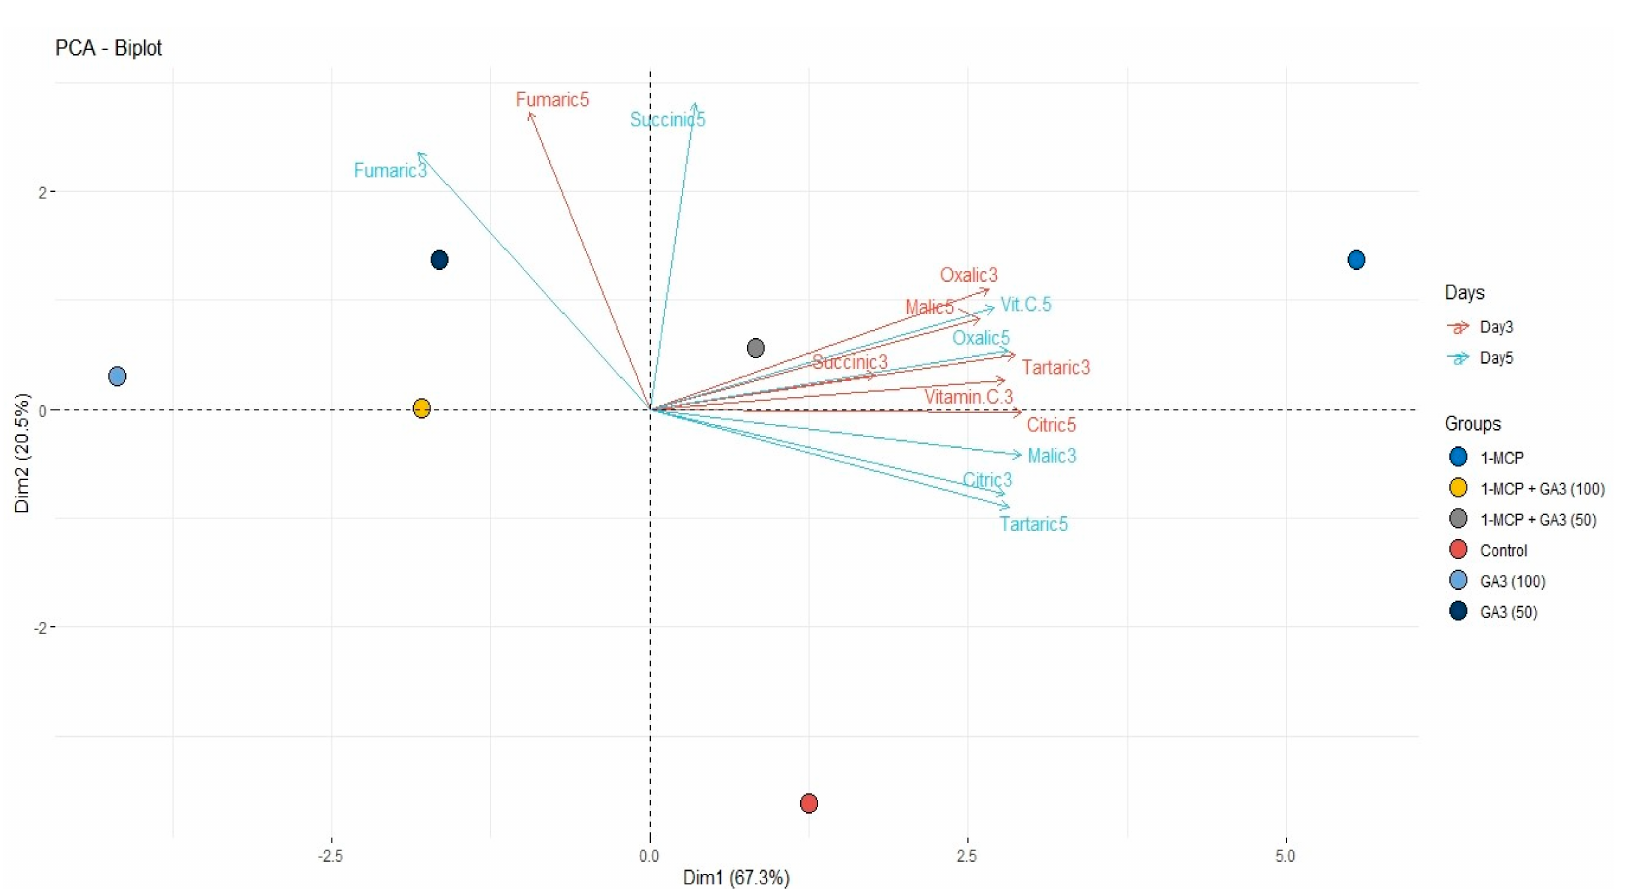
Figure 1. Distribution of organic acids, vitamin C, and treatments on the